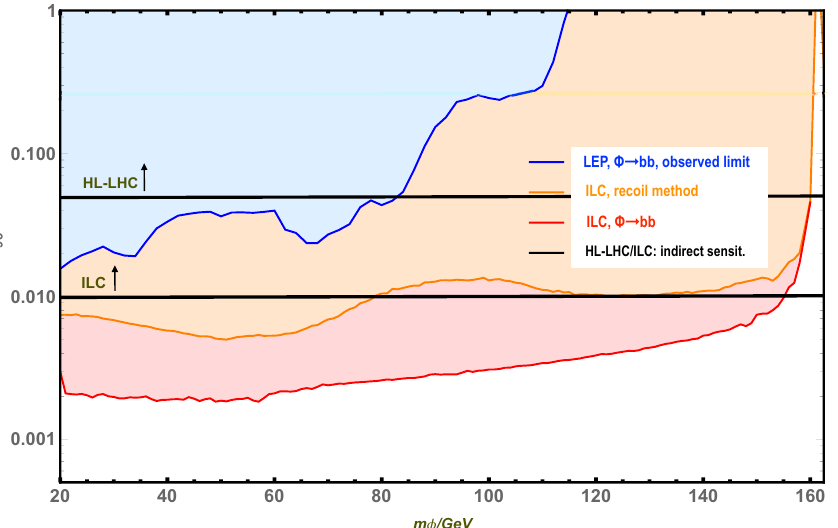
measured, LEP (cid:1) ( mH )